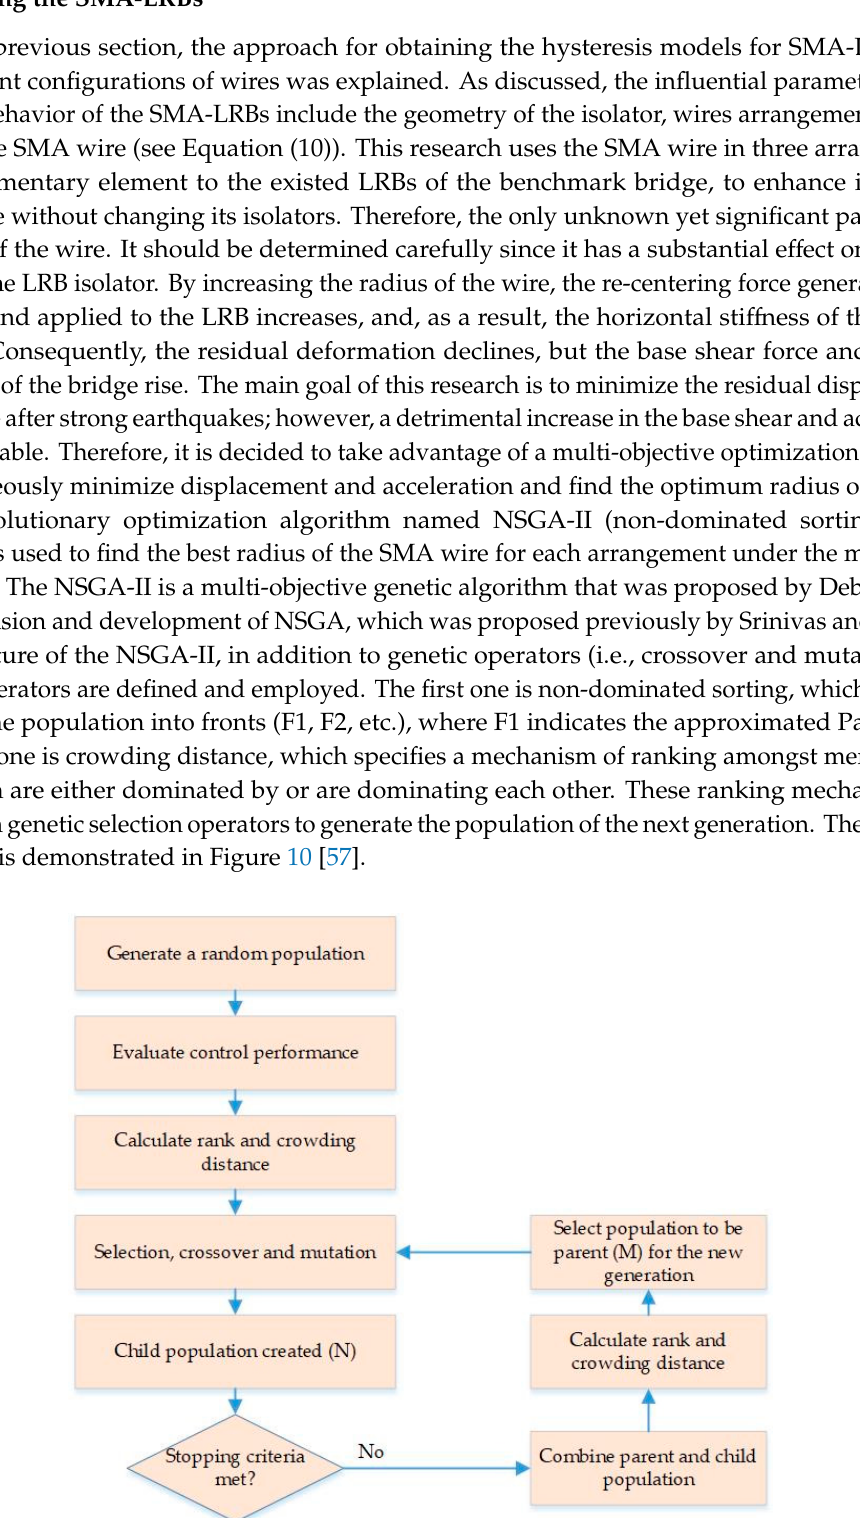
Figure 11. Pareto Front of NSGA-II for the three wire configurations. 6. Numerical Analysis In order to assess the performance of the three optimized SMA-LRBs, the seismic responses of the highway bridge equipped with the SMA-based isolators are calculated and compared with those